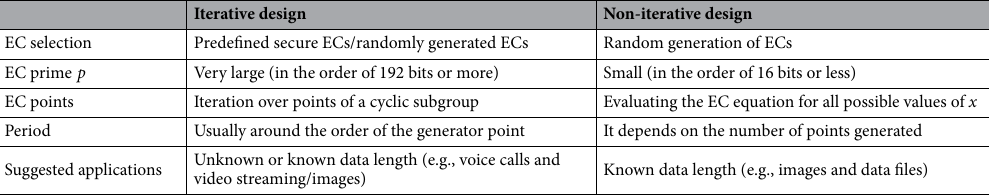
Table 1. Comparing iterative and non-iterative designs.